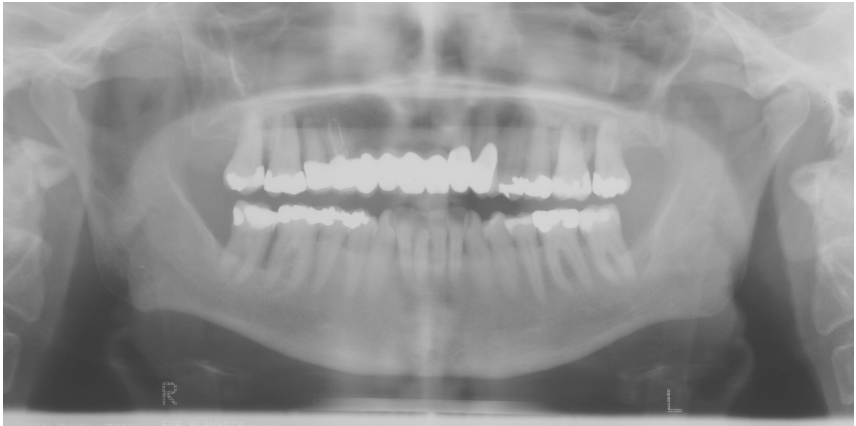
Figure 3. Same patient 12 months before: periodontal destruction was misdiagnosed and treated as aggressive periodontits.